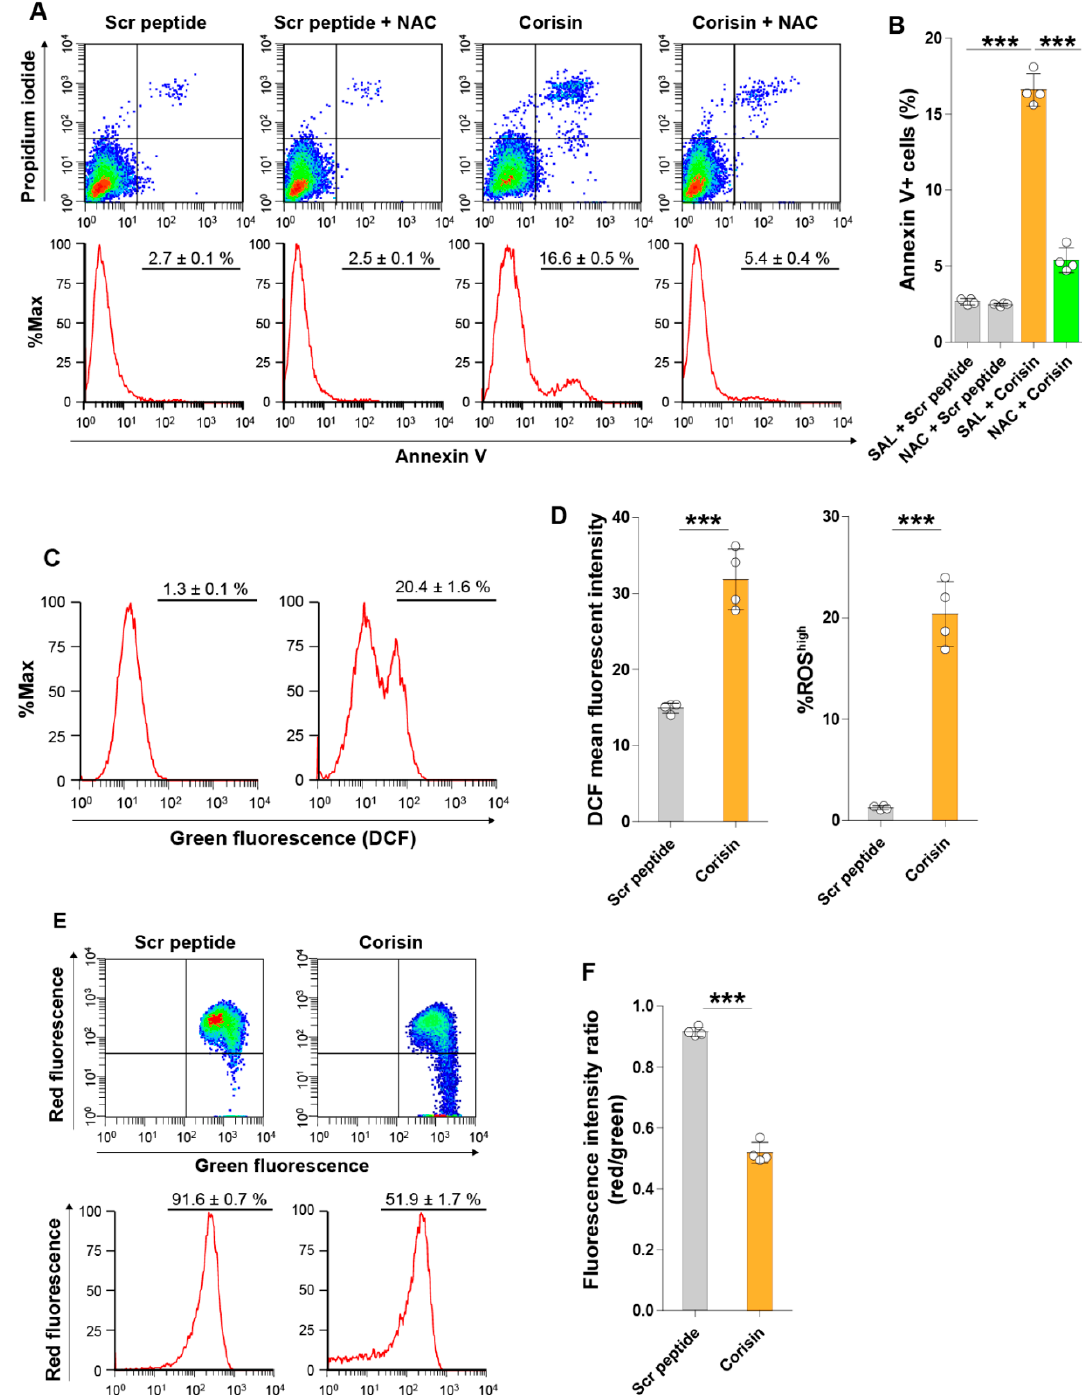
Figure 6. Treatment of intestinal cells is associated with increased generation of reactive oxygen species (ROS) and mitochondrial membrane depolarization. Caco-2 cells were pre-incubated with or without N-acetyl-l-cysteine and then treated with 10 μ g/ml of corisin or scrambled peptide before evaluating apoptosis by flow cytometry ( A , B ). To detect cellular ROS, Caco-2 cells were treated with 5 μ M corisin or scrambled peptide, washed with phosphate-buffered saline, incubated with medium containing 2 ′ ,7 ′ -dichlorofluorescin diacetate (DCFDA) and then evaluated by flow cytometry ( C , D ). The JC-1 dye was used to evaluate mitochondrial membrane integrity. Caco-2 cells were treated with corisin or scrambled peptide, and then cells were stained with JC-1 before assessing by flow cytometry ( E , F ). Data are expressed as the mean ± S. D. Statistical analysis by ANOVA with Newman-Keuls' test. *** p < 0.001.